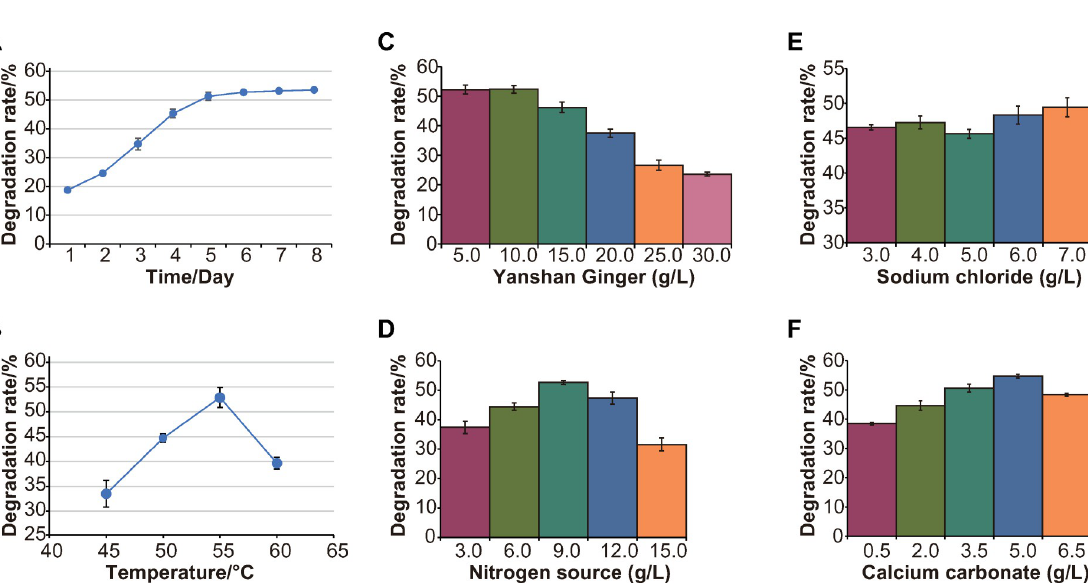
Fig 3. Optimization of YSJ culture conditions. (A) The effect of culture duration on degradation ability of YSJ. (B) The effect of culture temperature on the degradation ability of YSJ ( p � 0.05). (C) Effect of carbon source addition on YSJ degradation ability ( p � 0.05). (D) Effect of nitrogen source addition on YSJ degradation ability ( p � 0.05). (E) Effect of sodium chloride addition on the degradation ability of YSJ. (F) Effect of calcium carbonate addition on YSJ degradation ability ( p �